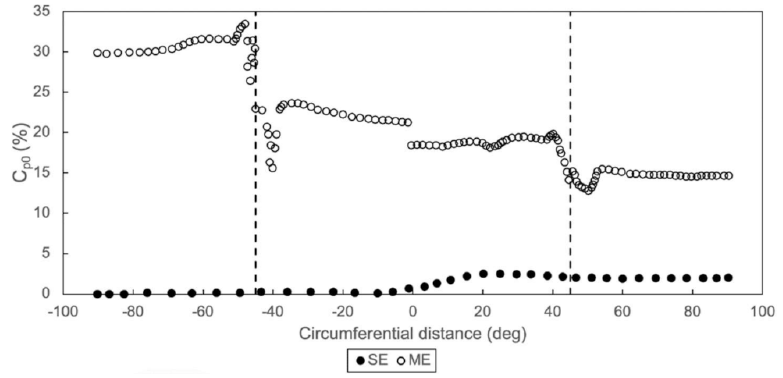
Figure 8. Circumferential distribution of C p0 across the midplane of the manifold for both single– entry and multiple–entry cases at 100% mass flow rate